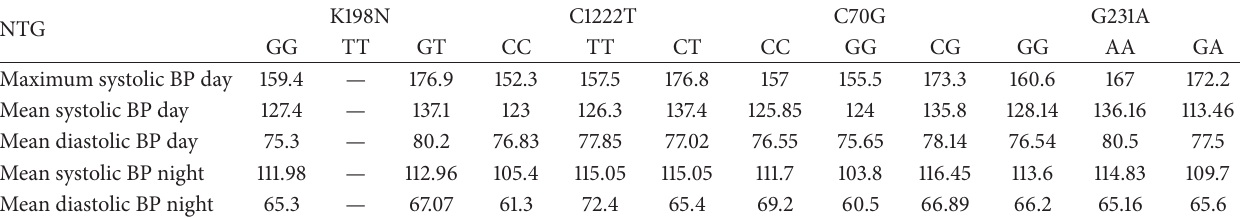
Table 10: Relation between mean blood pressure (BP) (mmHg) and polymorphic variants in NTG